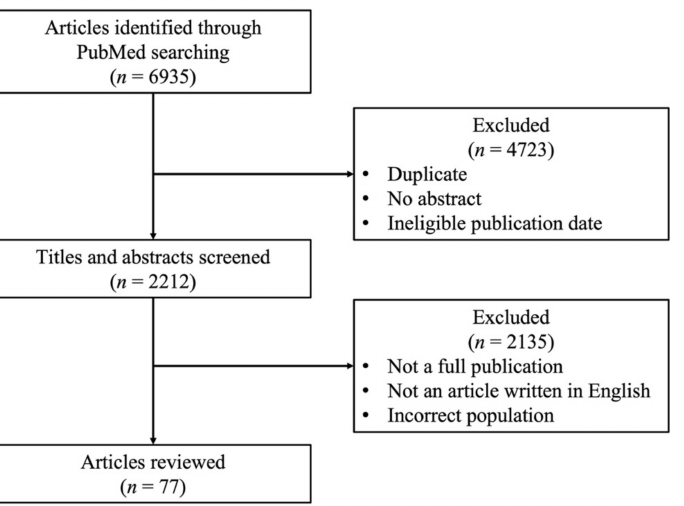
Figure 1. Literature flow chart of the PubMed database using terms of “breast” AND (“neuroen- docrine carcinoma” OR “neuroendocrine tumors” OR “neuroendocrine